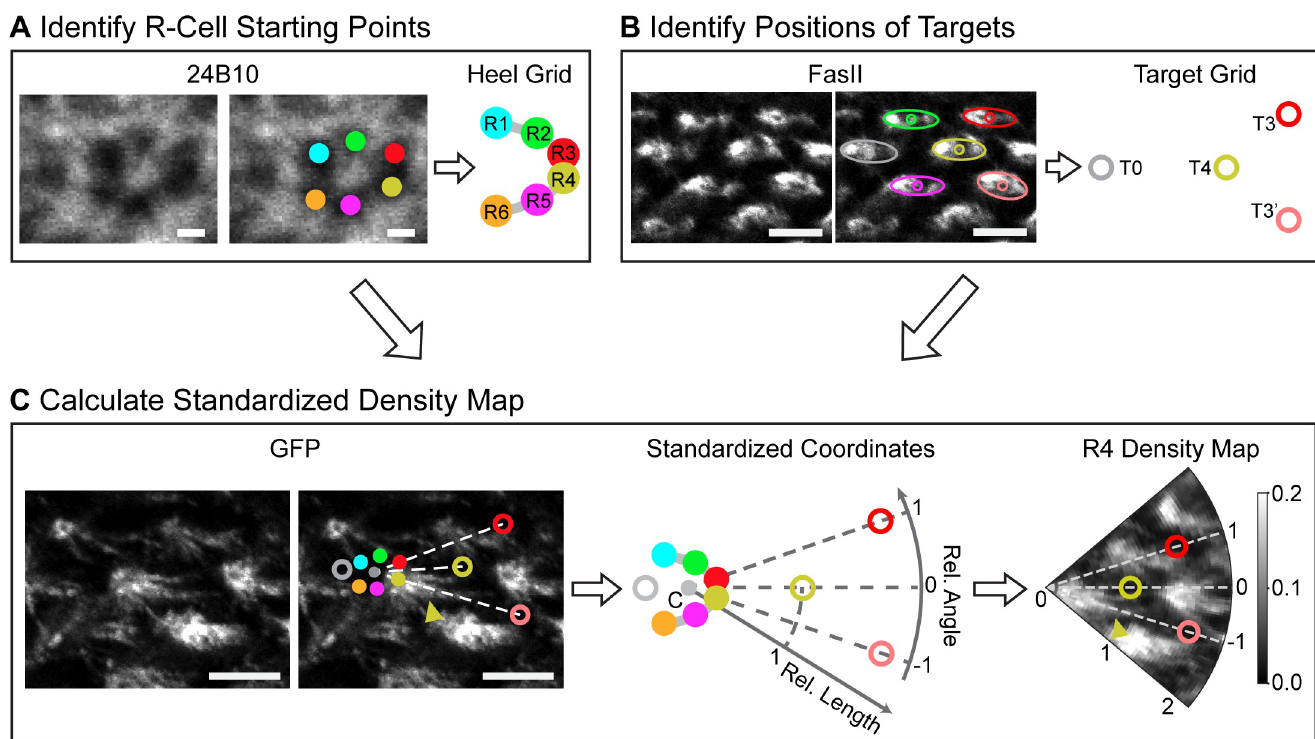
Fig 2. Establishment of standardized coordinates for comparison of growth cone extension. Overview of the image quantification process. (A) The heel grid (i.e., R-cell extension starting points) is identified (via 24B10 antibody labeling R-cell membranes; Materials and Methods). (B) The target grid is identified (via FasII antibody labeling L-cell membranes; Materials and Methods). (C) In each region, (left) the annotation (from A-B) is used (middle) to produce standardized coordinates that are used (right) to transform confocal images into standardized density maps. This transformation allows relative lengths (radial coordinate) and angles (angular coordinate) of extending growth cones to be compared across regions. Images: confocal images of a sample bundle region from one wild-type fly at 26 hrs APF. Images were cropped, re-oriented and intensity scaled for visualization (Materials and Methods). Arrowheads highlight growth cones of interest. Scale bars: 5 μ m for FasII and GFP images; 1 μ m for 24B10